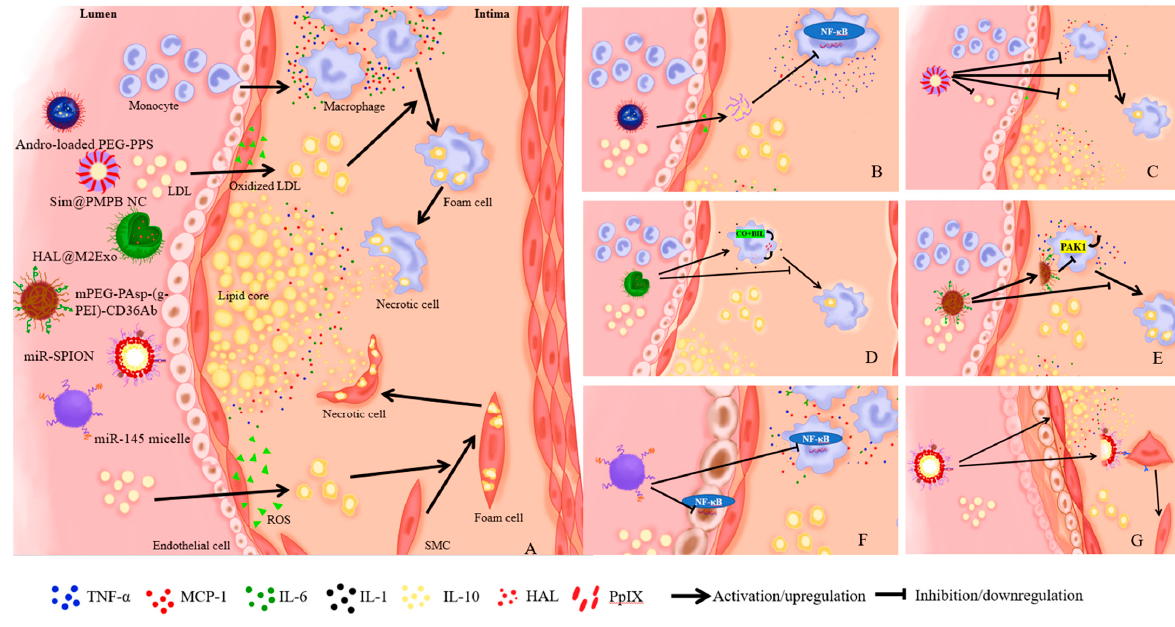
Figure 2. The mechanism of nanomedicines of different strategies for AS treatment. ( A ) shows the pathological processes of AS. ( B ) shows that Andro-loaded PEG-PPS could scavenge excess ROS, inhibit the expression of pro-inflammatory cytokines IL-6 and MCP-1, as well as block NF- κ B sig- naling pathway, to dampen inflammation [18]. ( C ) shows that Sim@PMPB NC could scavenge ex- cess ROS, inhibit expression of pro-inflammatory cytokines (IL-6, MCP-1 and TNF- α ), reduce LDL, inhibit oxidized LDL internalization and foam cell formation [43]. ( D ) shows that HAL@M2exo could secrete anti-inflammatory cytokines IL-1 and IL-10, increase anti-inflammatory capacity by CO and bilirubin, inhibit oxidized LDL internalization and foam cell formation [46]. ( E ) shows that mPEG-PAsp-(g-PEI)-CD36Ab could reduce CD36 expression by target macrophages, inhibit upreg- ulation of IL-6 and MCP-1 by silencing PAK1 gene, and decrease the formation of foam cells [48]. ( F ) shows that miR-SPION could downregulate NF- κ B signaling pathway both in macrophages and endothelial cells, and further reduce inflammation [50]. ( G ) shows that miR-145 micelle could target the CCR2 expressing in vascular SMCs, promote the transition of SMCs from synthetic phenotype to contractile phenotype, and reduce the size of plaque lesions and necrotic core area [51].